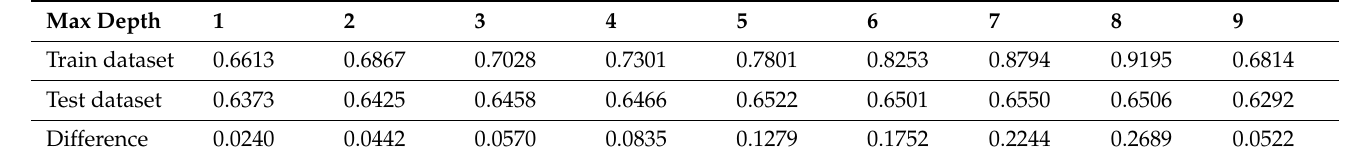
Table 5. The pattern of AUROCs in train and test